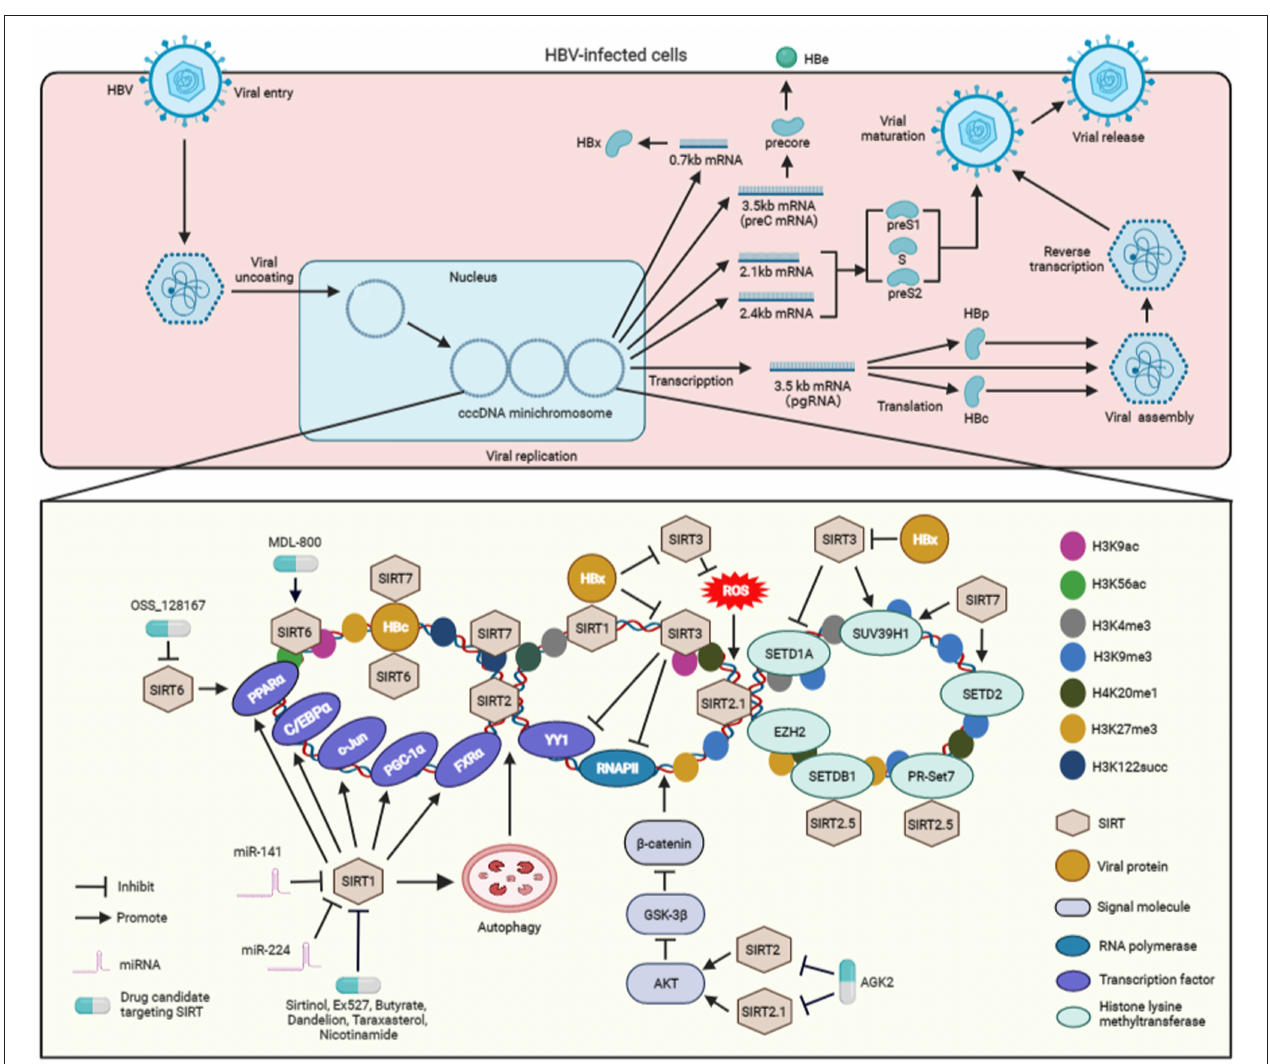
FIGURE 1 | The molecular mechanisms associated with the regulation SIRT-mediated HBV replication and the SIRT-targeting antiviral agents to inhibit viral replication. After entering hepatocytes, HBV is uncoated and transferred into the nucleus and its genome is converted into cccDNA. Subsequently, the cccDNA forms a mini-chromosome and is transcribed into various viral mRNA, including pregenomic RNA (pgRNA) and preC mRNA, two envelope mRNAs, and X mRNA. The pgRNA serves as a translation template for HBc and viral polymerase proteins (HBp). The preC mRNA encodes pre-core protein, which is secreted as HBe antigen. X mRNA is translated to HBx protein. The two envelope mRNAs encode preS1, S, and preS2 domains to construct the various viral surface proteins. The pregenomic RNA is encapsulated into viral particles, and reverse-transcribed into viral DNA. The enveloped HBV particles are secreted from the HBV-expressing hepatocytes. During the cccDNA mini-chromosome-dependent HBV replication, SIRT1 interacts with HBx and then recruited to cccDNA. SIRT1 activates the transcription factors, inculding FXR α , PGC-1 α , c-Jun, C/EBP α , and PPAR α , which can promote the activation of HBV promoters, to facilitate viral replication. In addition, SIRT1 also enhances HBV replication via autophagy. However, miR-141 and miR-224 inhibit SIRT1 to block autophagy-mediated viral replication. SIRT2 and SIRT2.1 increase the replication of HBV via activating AKT, inhibiting GSK-3 β , and then sensitizing the β -catenin signaling. SIRT2.5 recruits histone methyltransferases, including SETDB1, EZH2, SUV39H1, PR-Set7, and H3K27me3, H3K9me3, and H4K20me1 to cccDNA. The interactions of PR-Set7 and SETDB1 with SIRT2.5 are increased upon HBV replication. Upon recruitemnt to HBV mini-chromosome, SIRT3 can lead to an increase in histone lysine methyltransferases SUV39H1 but a decrease in SETD1A on viral cccDNA, which results in increased recruitment of H3K9me3 but decreased binding of H3K4me3 to HBV cccDNA. SIRT3-mediated viral cccDNA transcriptional repression is similar to the decreased recruitment of RNAPII and transcription factor YY1 on the viral cccDNA. HBx enhances cccDNA transcription by suppressing the expression of SIRT3 and inhibiting the recruitment of proteins to cccDNA. In addition, SIRT3 overexpression inhibits viral replication by reducing cellular ROS level. HBx can induce ROS production to promote viral replication, which is associated with the inhibition of SIRT3. SIRT6 activates the HBV promoters via upregulating PPAR α expression. However, SIRT6 is able to repress HBV replication via interacting with HBc and downregulating H3K56 acetylation (H3K56ac) and H3K9 acetylation (H3K9ac) on the viral cccDNA mini-chromosome. SIRT7 binds to cccDNA by interacting with HBc and inducing the decrease of H3K122 succinylation (H3K122succ). Specifically, SIRT7 cooperates with SETD2 and SUV39H1 to induce the inhibition of viral transcription. The inhibitors, including sirtinol, Ex527, butyrate, dandelion, taraxasterol, and nicotinamide, can suppress viral replication via SIRT1-targeting. The inhibitor AGK2 suppresses HBV replication by blocking SIRT2 and SIRT2.1. OSS_128167, a SIRT6 inhibitor, can repress HBV replication. Whereas, MDL-800 can suppress viral replication by activating SIRT6. ROS, reactive oxygen species; RNAPII, RNA polymerase II; H3K9me3, trimethyl-H3K9; H4K20me1, monomethyl-H4K20; H3K27me3, trimethyl-H3K27; H3K4me3, trimethyl-H3K4; H3K9ac, H3K9 acetylation; H3K56ac, H3K56 acetylation; H3K122succ, succinylation of histone H3K122; SETDB1, SET domain bifurcated 1; EZH2, enhancer of zeste homolog 2; SETD1A, SET domain containing 1A; SUV39H1, suppressor of variegation 3–9 homolog 1; cccDNA, covalently closed circular DNA.